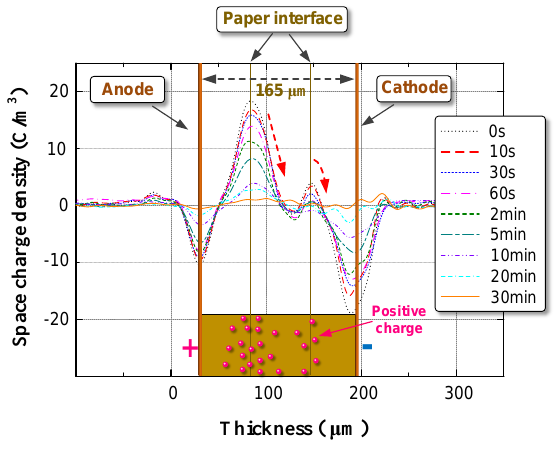
Figure 14. Space charge decay characteristics of OIP.